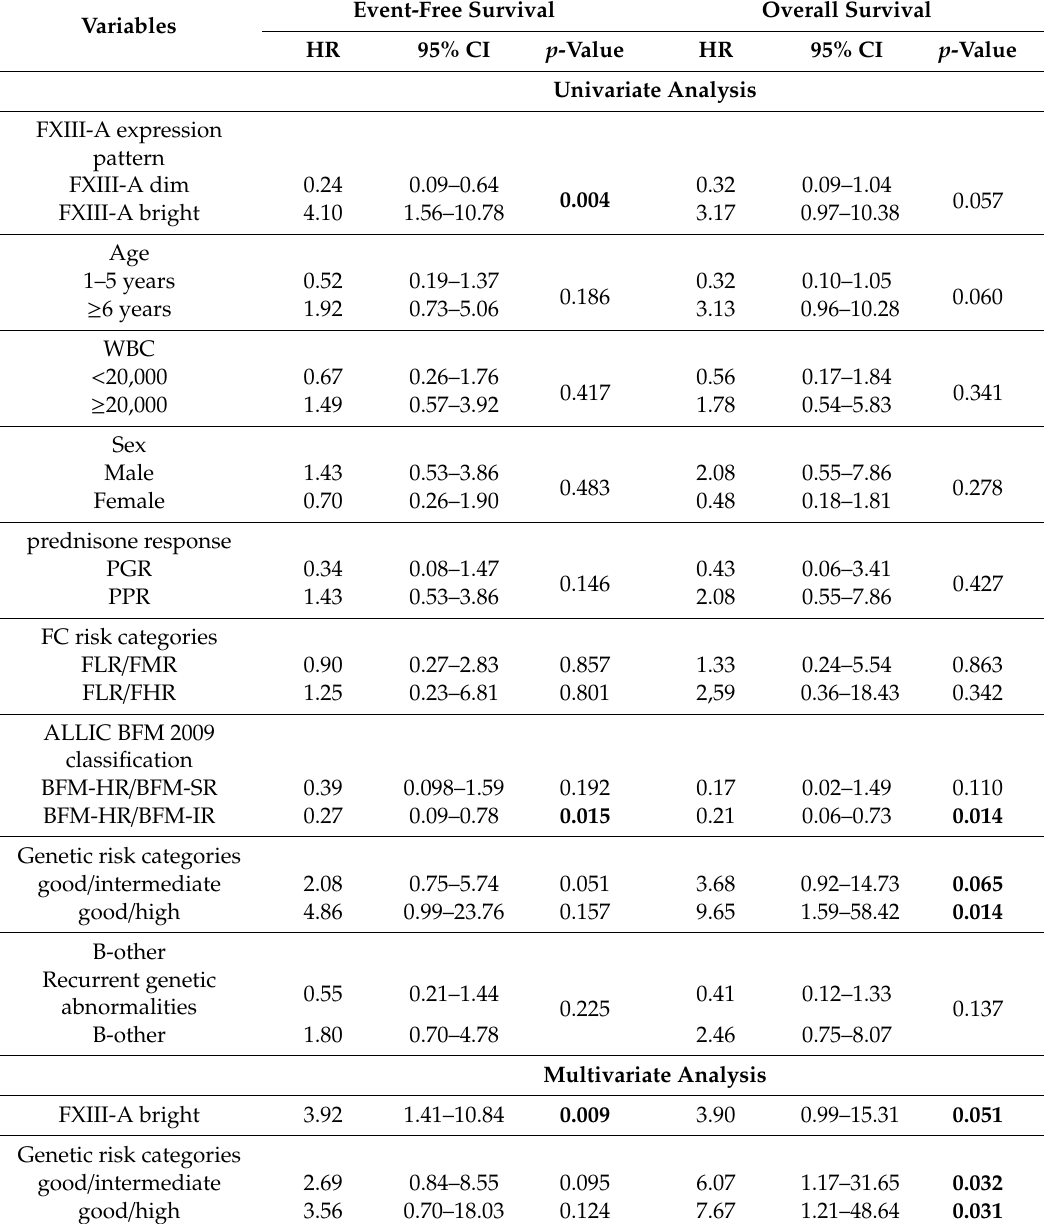
Table 2. Association of categorical variables on event-free survival (EFS) and OS of the FXIII-A dim vs. bright groups by univariate and multivariate Cox regression